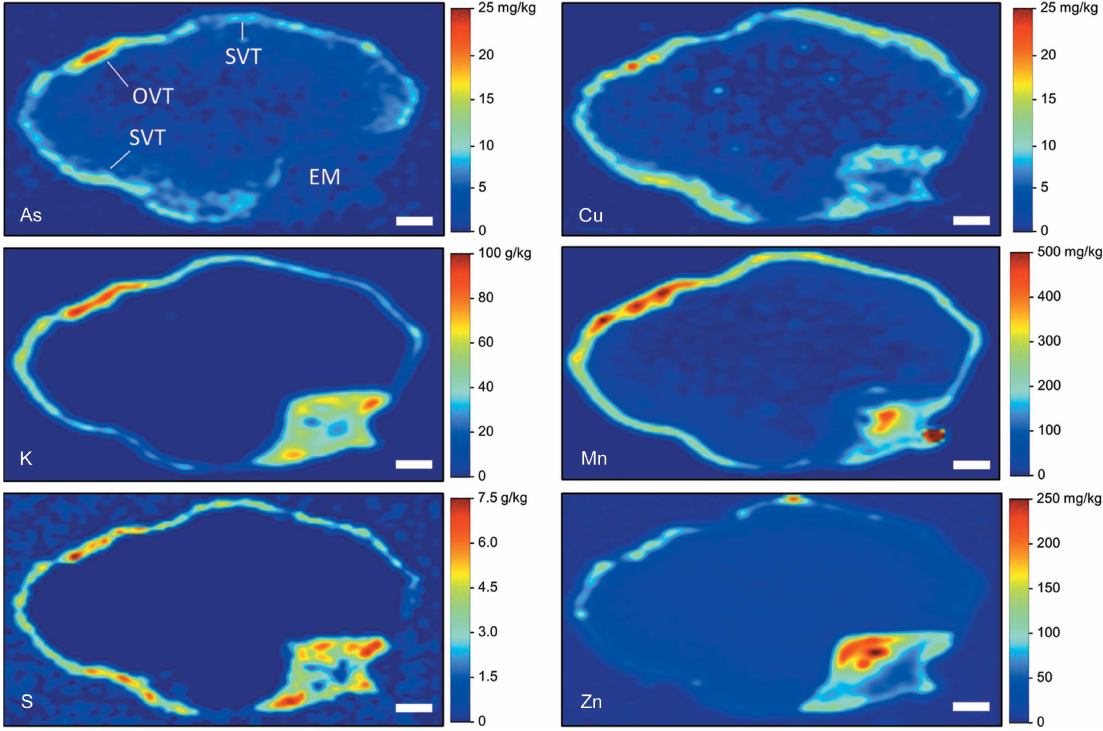
Figure 4 Quantitative SR- m XRF elemental concentrations in the cross-section of a rice grain grown in soil with elevated levels of As ( (cid:3) 24 mg kg (cid:2) 1 ). Scale bar denotes 300 m m. EM: